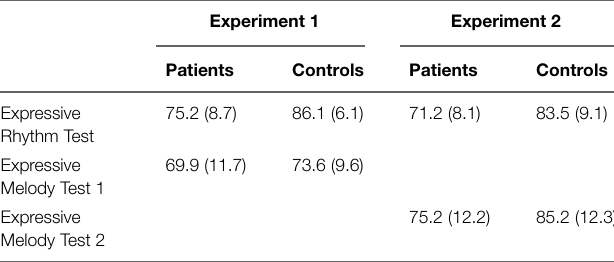
TABLE 4 | Mean values (%) of correct answers for expressive tests ( ± one standard